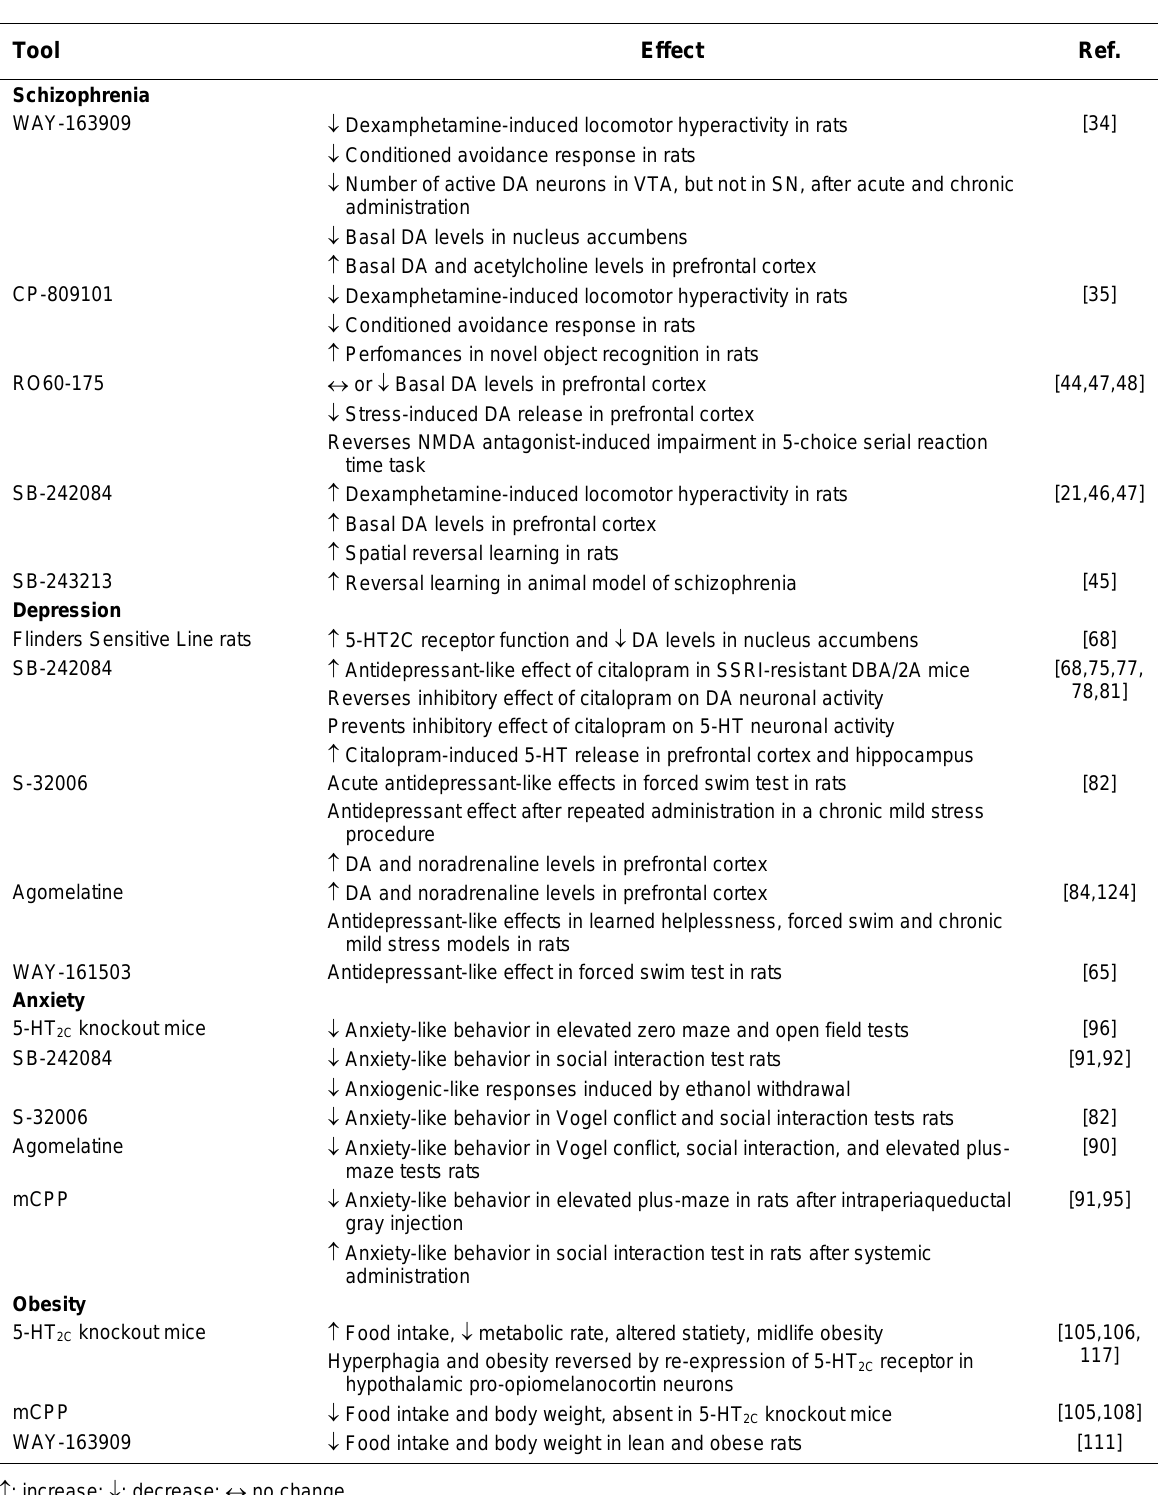
Receptor Modulation 2C